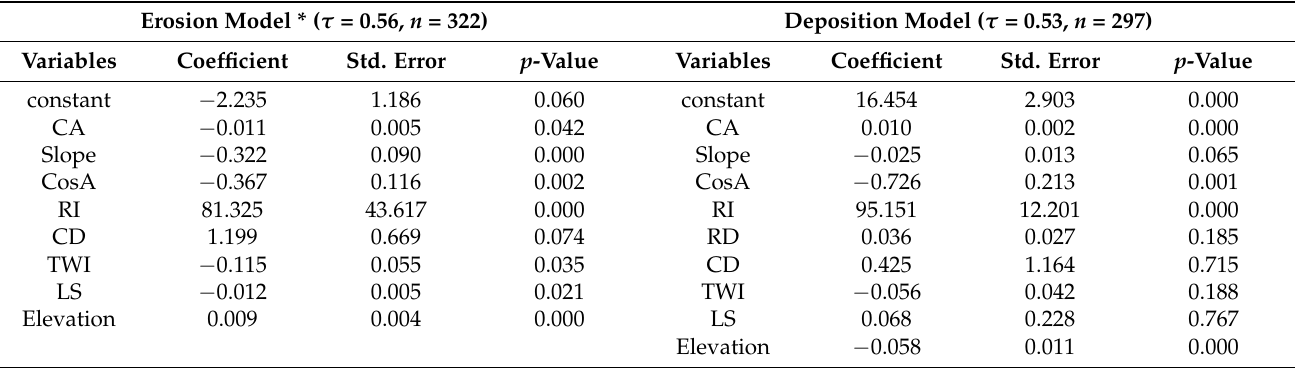
Table 5. Coefficients of the QR models for erosion and deposition (December 2014–March 2015).